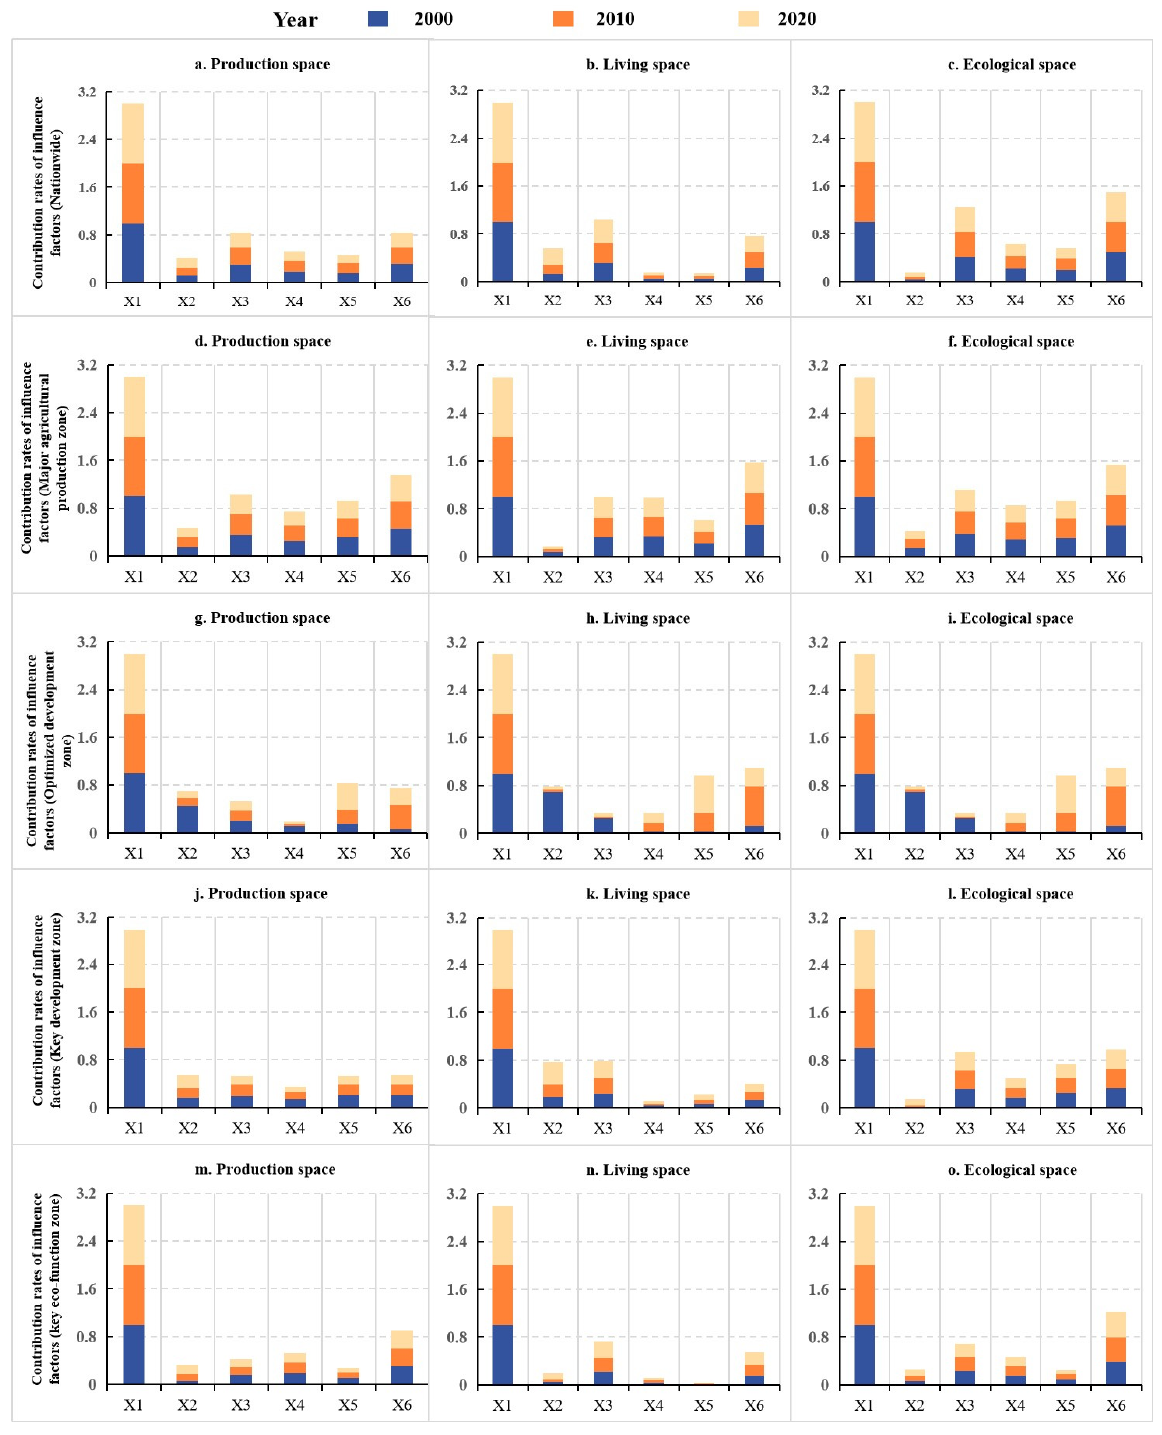
Figure 9. Contribution rates of influence factors from 2000 to 2020. Notes: Variables X 1 – X 6 in the figure represent land use intensity, NDVI, population density, average annual temperature, average annual precipitation, and average elevation, respectively.